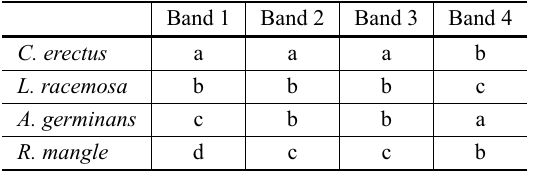
Duncan’s test results for mangrove species, same letters indicate similar